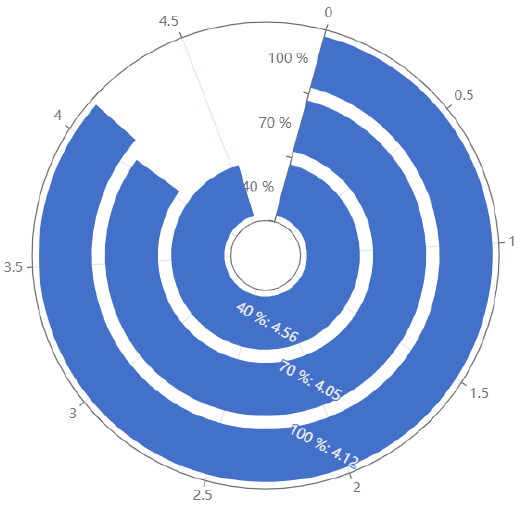
Figure 13. DSSR hyperplane fitting error with different power outputs.